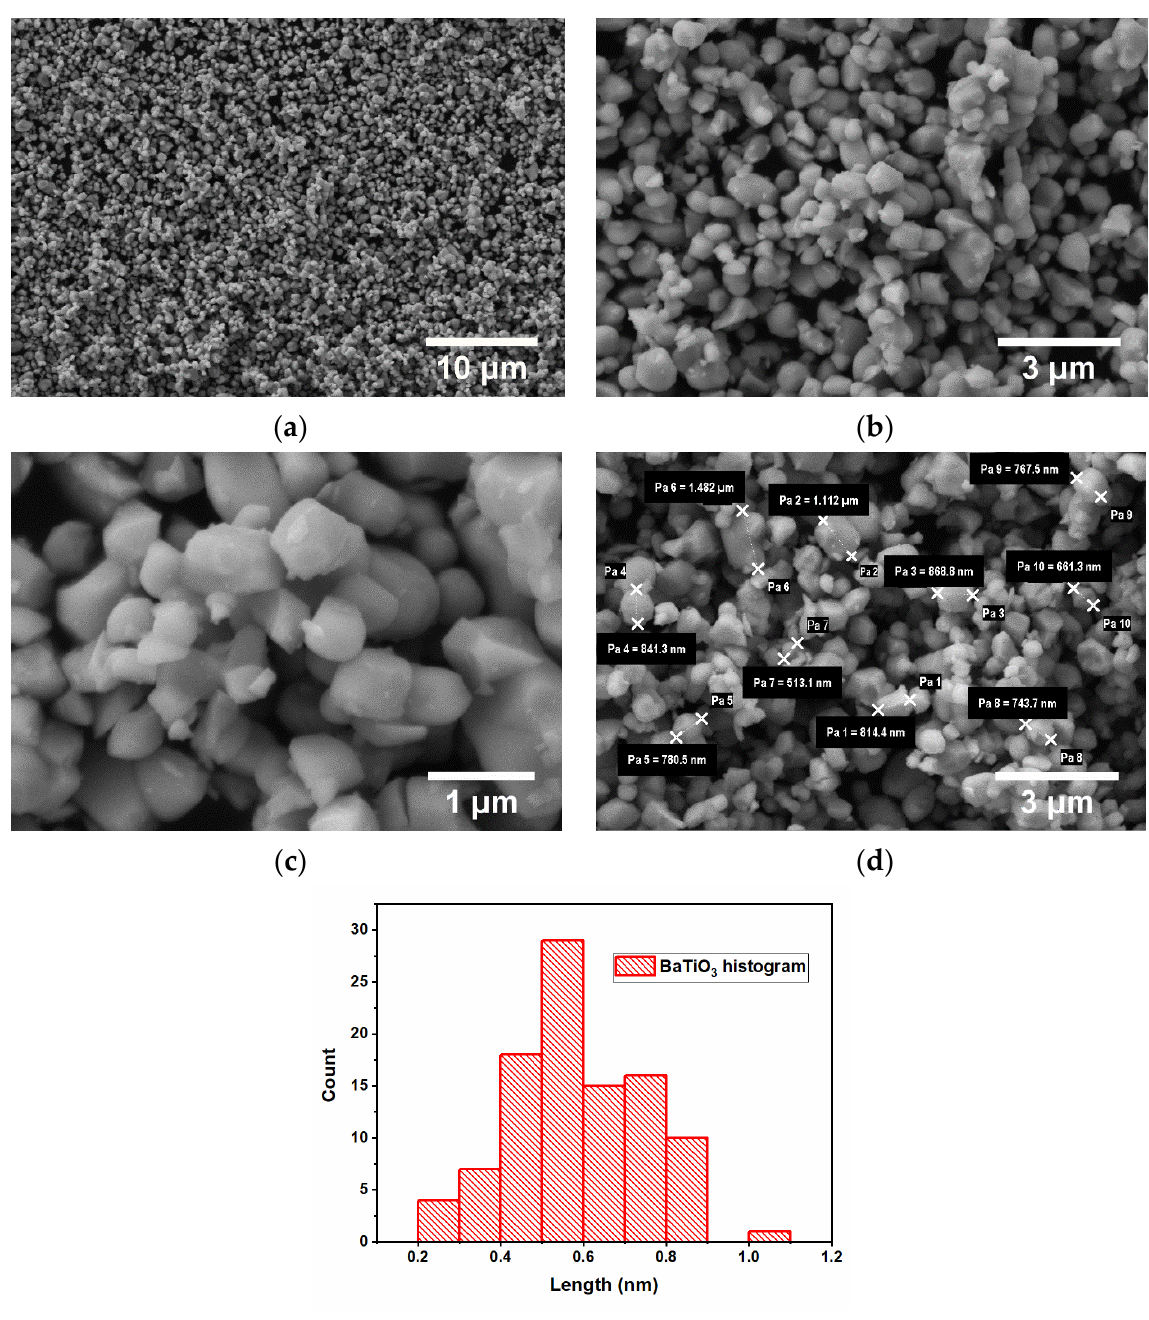
Figure 13. SEM images for PP at magnifications 1.000× ( a ) and 10.000× ( b ). For the BaTiO 3 powder, the micrographs are shown in Figure 14. A large dispersion of particle sizes is found.